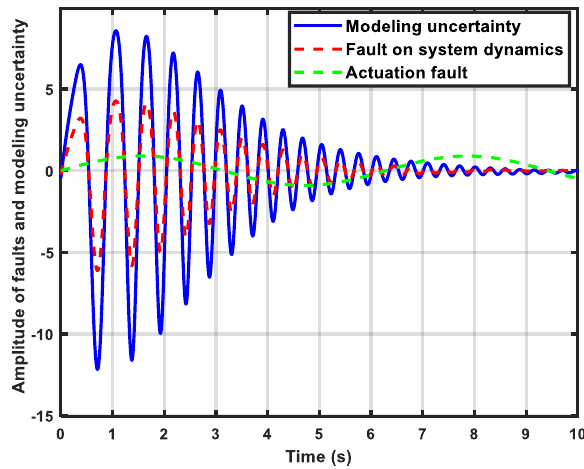
Figure 4. Comparison of fault trajectories and modeling uncertainty.